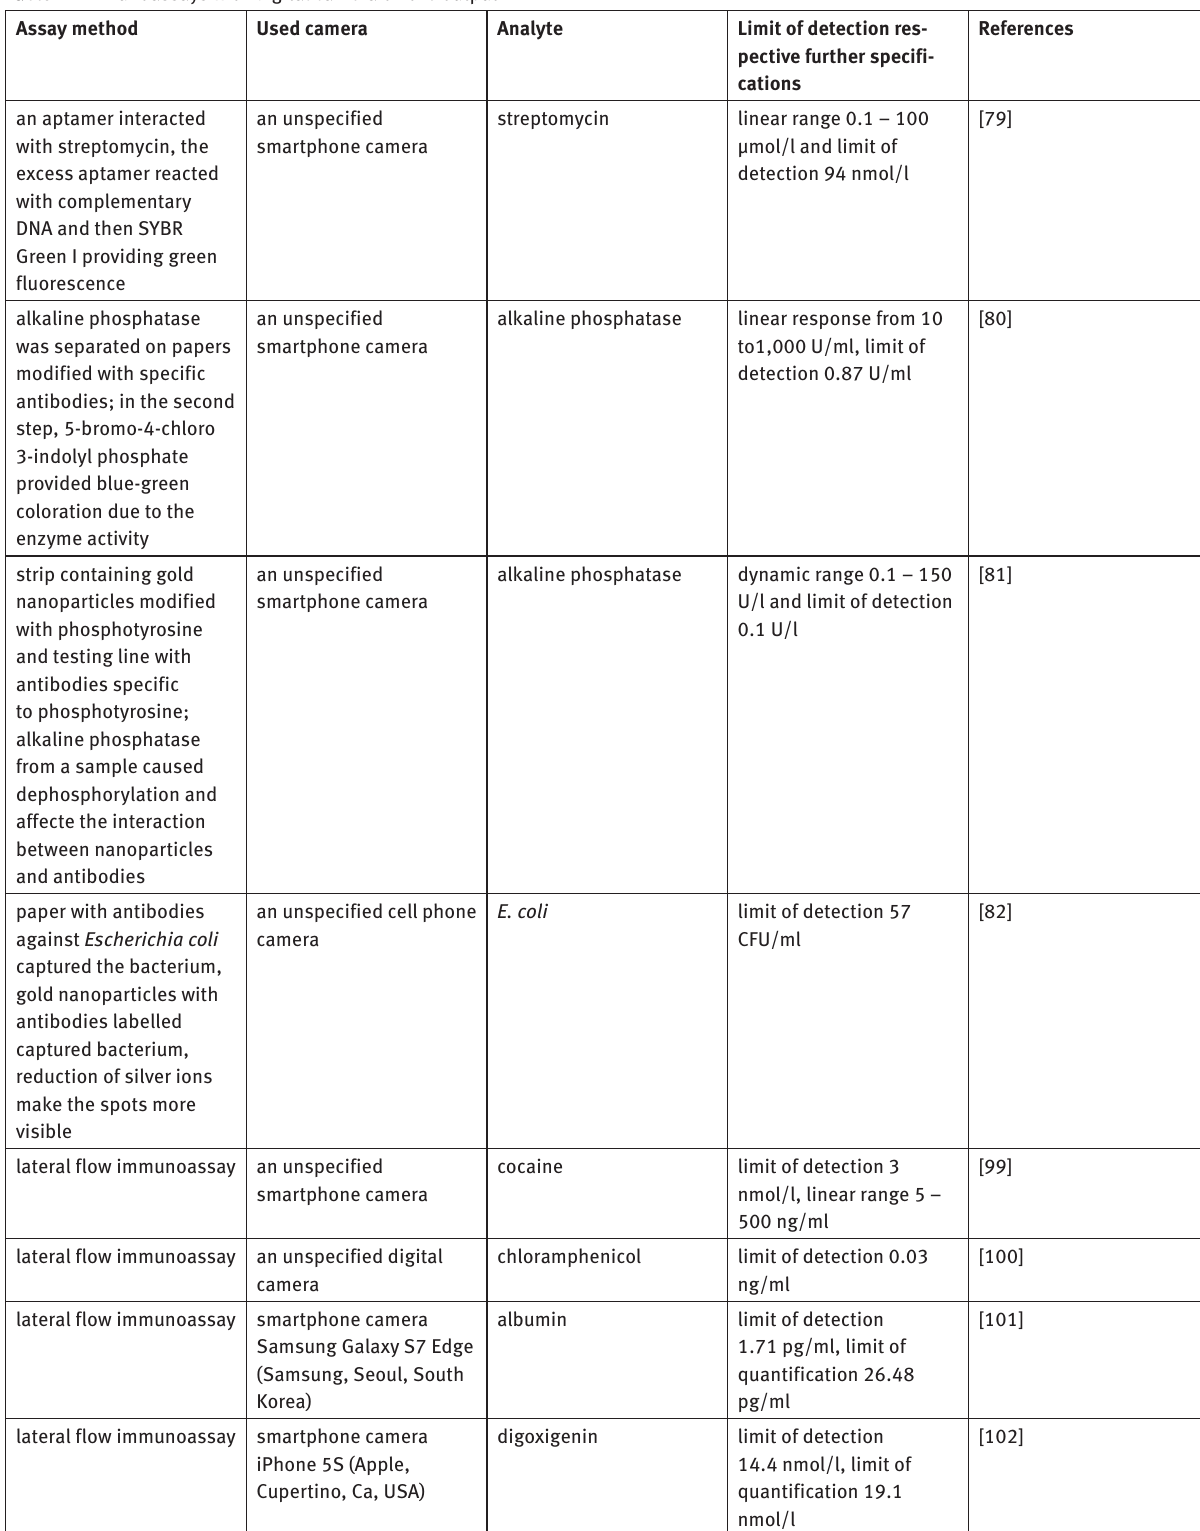
Table 2 Immunoassays with digital camera on the output Assay